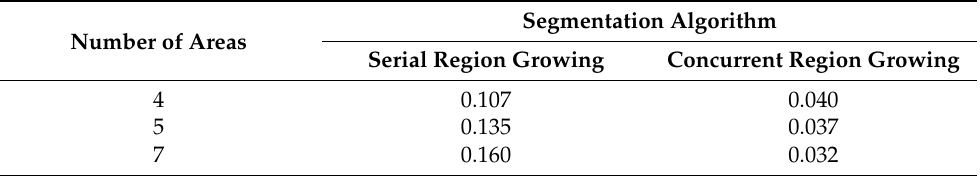
Table 9. Zeboudj’s contrast for 4, 5, 7 regions (Serial Region Growing, Concurrent Region Growing), CTS video sequences.